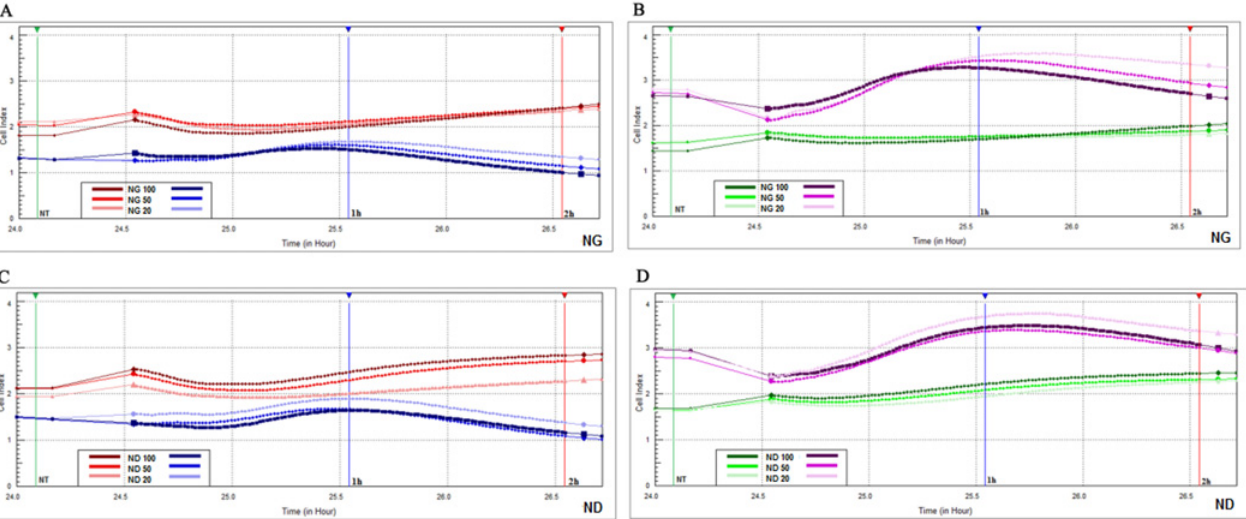
Fig 4. Glioblastoma and hepatoma cells status (CI). U87, U87-EGFP, C3A and C3A-EGFP CI monitored by a real-time cell analyzer (RTCA) after 1 and 2 h of exposure to the culture medium containing graphite and diamond nanoparticles at different concentrations: diamond 20 μ g/mL (ND 20), 50 μ g/mL (ND 50) and 100 μ g/mL (ND 100), and graphite 20 μ g/mL (NG 20), 50 μ g/mL (NG 50) and 100 μ g/mL (NG 100); nontreated cells were used as a control (NT). ( A ) U87 (blue lines) and C3A cells (red lines) treated with graphite (NG) after 1 h (vertical blue marker line) and 2 h (vertical red marker line) and control (vertical green marker line); ( B ) U87-EGFP cells (violet lines) and C3A-EGFP cells (green lines) treated with graphite after 1 h (vertical blue marker line) and 2 h (vertical red marker line) and control (vertical green marker line); ( C ) U87 (blue lines) and C3A cells (red lines) treated with diamond (ND) after 1 h (vertical blue marker line) and 2 h (vertical red marker line) and control (vertical green marker line); ( D ) U87-EGFP cells (violet lines) and C3A-EGFP cells (green lines) treated with diamond (ND) after 1 h (vertical blue marker line) and 2 h (vertical red marker line) and control (vertical green marker line). Data analysis was carried out by two-way ANOVA and the differences between the groups were tested by Duncan ’ s test. Data were averaged from three replicates (n = 3); P < 0.05. No significant interaction (nanoparticles with transduction) was observed. doi:10.1371/journal.pone.0122579.g004 CI for U87 at 50 μ g/mL and 100 μ g/mL, and a 7.3% decrease at the highest concentration for U87-EGFP cells (Fig 4C; Fig 4D; blue/dark blue and dark violet lines, respectively). When the same cells were treated with medium containing ND for 2 h, a cytotoxic effect was only ob- served in nontransduced U87 cells (Fig 4C; blue and dark blue lines).